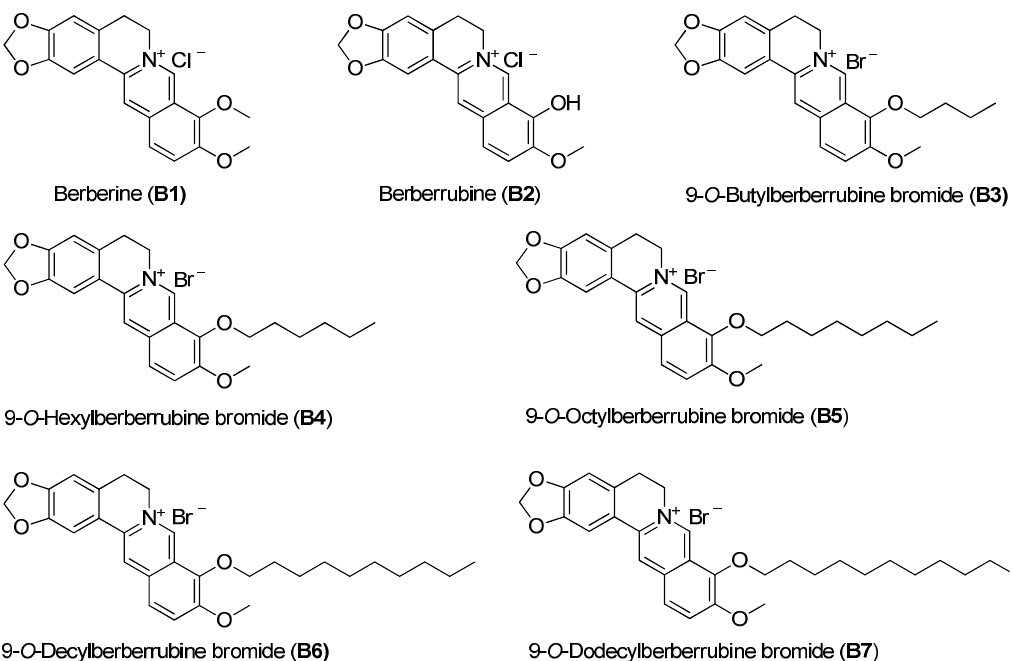
Figure 1. The chemical structures of berberine and its derivatives.